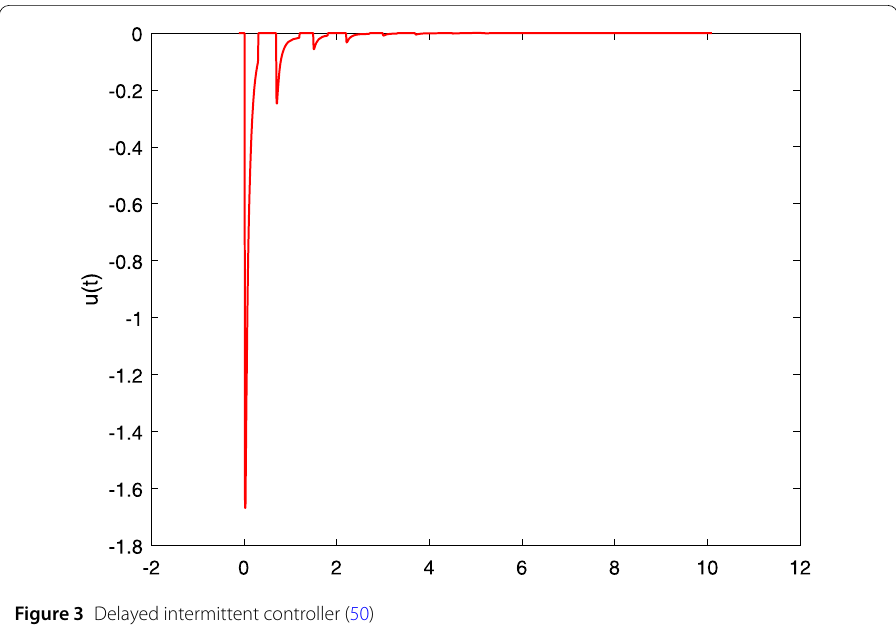
Figure 3 Delayed intermittent controller (50)